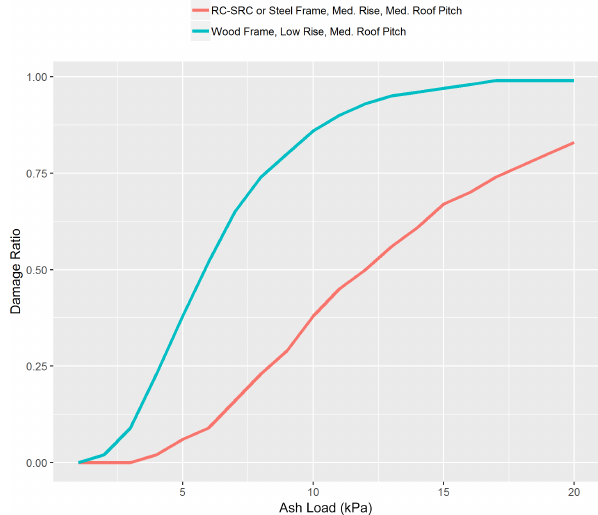
Figure 2. Damage functions for two different building types con- sidered in the volcano risk model (“RC-SRC” stands for reinforced concrete – steel reinforced concrete; “Med.” stands for medium); the source of these damage functions is Maqsood et al.